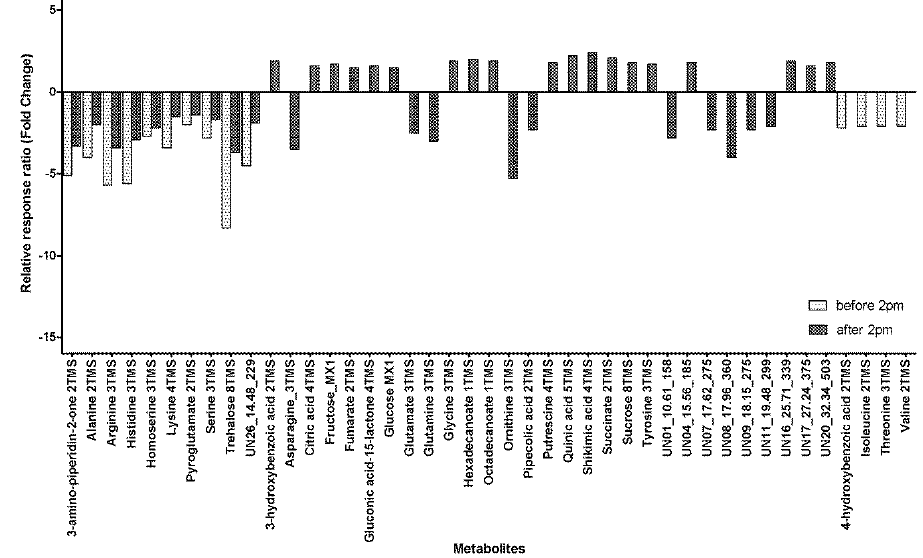
Figure 3. Fold change from 8–12 DAA to 17–21 DAA for metabolites in the phloem exudate metabolite profile with significant maturity variability in relative response ratios when collected at different times of day (before and/or after 14:00) (DAA, days after anthesis; xTMS, Trimethylsilyl derivative where x is the number of TMS groups; yMX, methoxyamine derivatized product where y = 1 or 2; Table S5 presents the values for the relative response ratios).